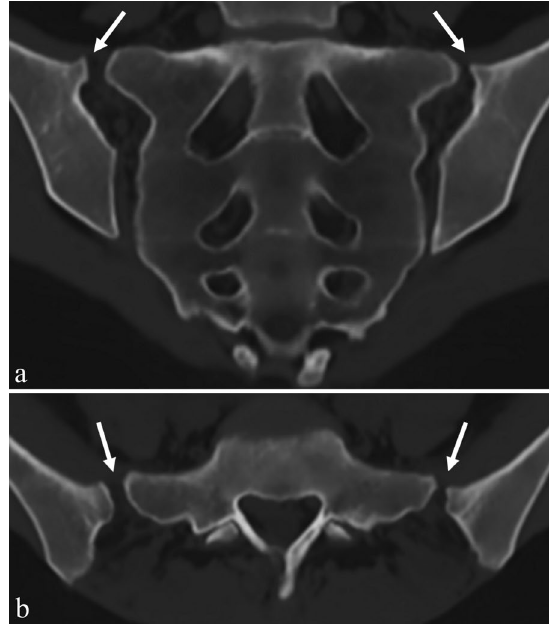
Fig. 3 New sacroiliac joint (SIJ) variant with extra joint facet superiorly. Semi-coronal ( a ) and semi-axial ( b ) synthetic CT images depict a newly found SIJ variant in a 27-year-old women, consisting of an accessory joint cranial of the cartilaginous part of the SIJ, between bony projections from the ilium (arrows) and the posterosuperior edge of S1 vertebra